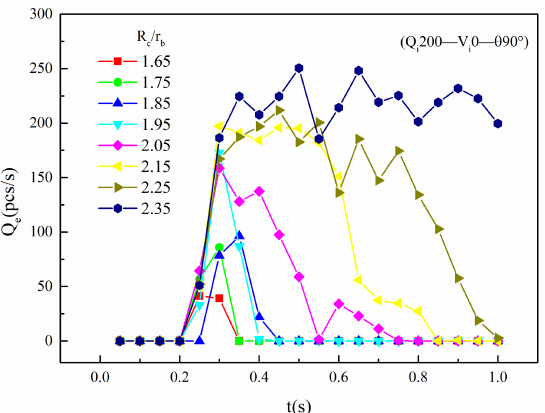
Figure 6. The variation of the flow rate of the bridging ball in the phase transition area in Figure 5.